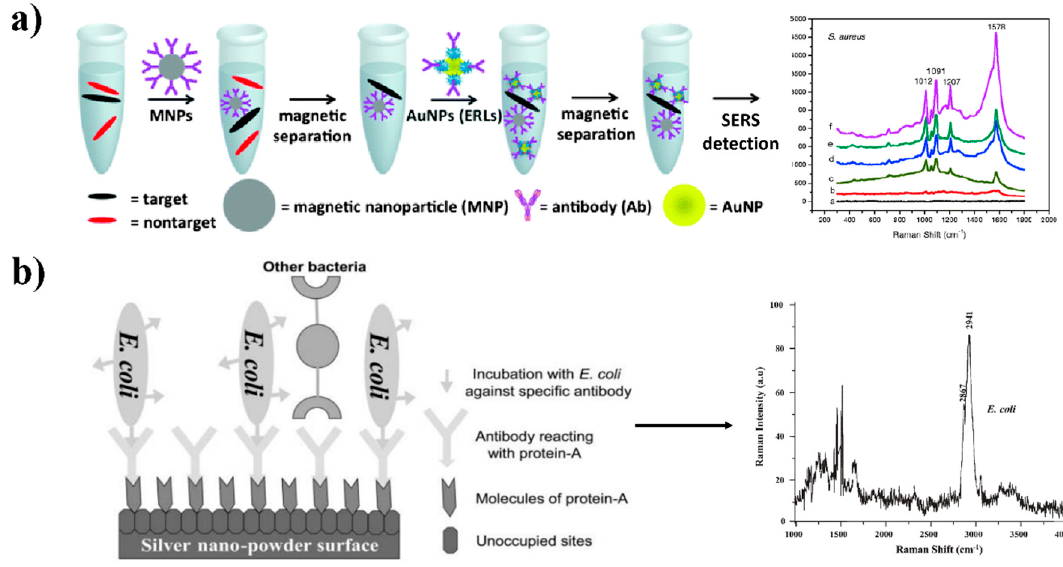
Figure 6. Representative “two-step” ( a ) and “one-step” ( b ) tandem-SERS sensing methods. ( a ) Tandem-SERS platform composed of the magnetic-based separation and SERS detection for multiple pathogens in food matrices. Pathogens were first captured with silica-coated magnetic probes, and then pathogen specific SERS probes (gold nanoparticles integrated with a Raman reporter and corresponding antibodies) were deployed to complete the following detection. ( b ) Schematic diagram for SERS-based detection of E. coli using silver nanoparticles conjugated with antibodies. Reproduced with permission [70]. Copyright Springer-Verlag, 2010. Reproduced with permission [102]. Copyright Royal Society of Chemistry, 2007.